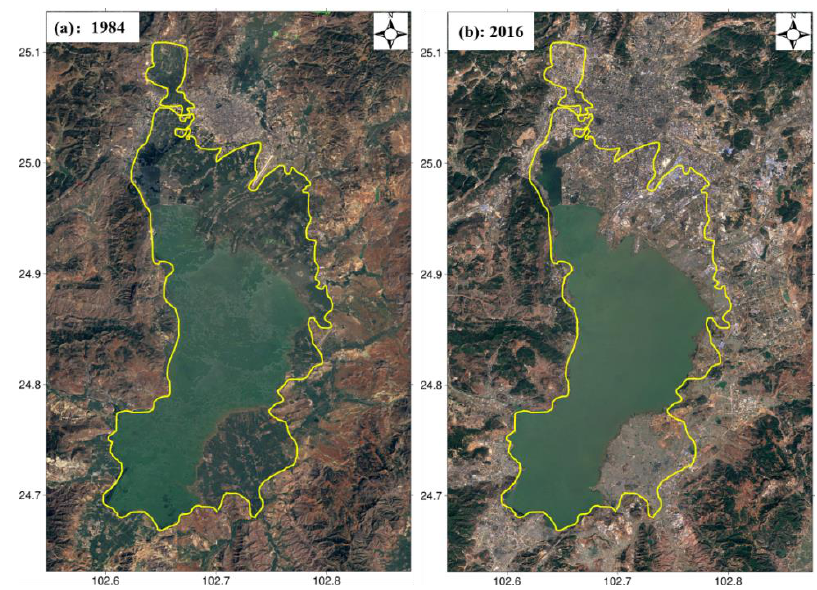
Figure 19. Changes in land cover over Kunming from ( a ) 1984 to ( b ) 2016; the yellow curve shows the main changes.